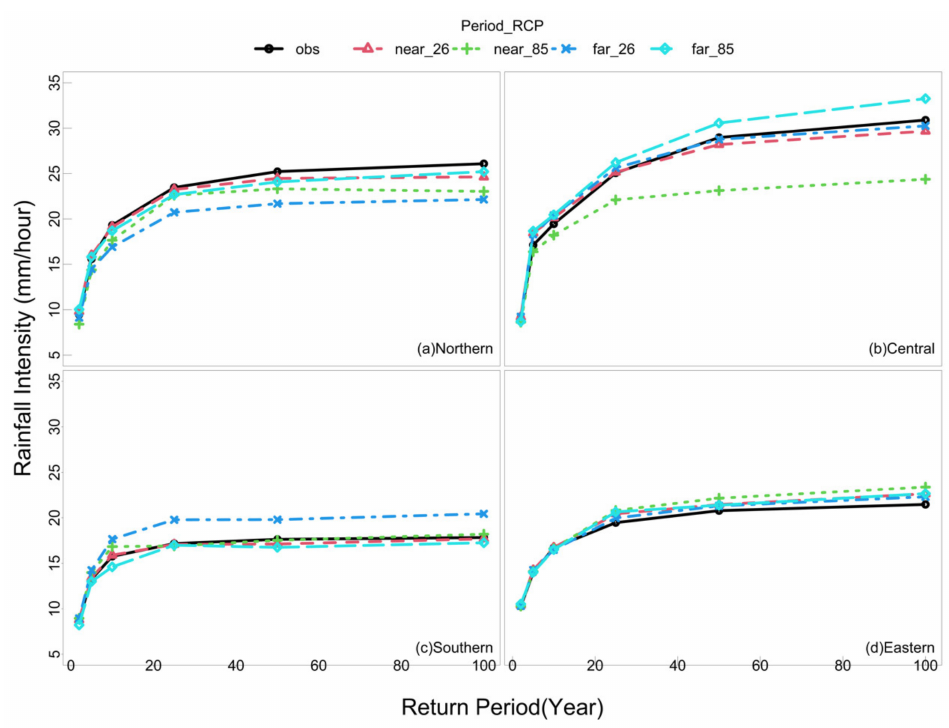
Figure 11. Rainfall intensities of events with twenty-four-hour duration (D24) changing with the return periods for the four regions and four scenarios.